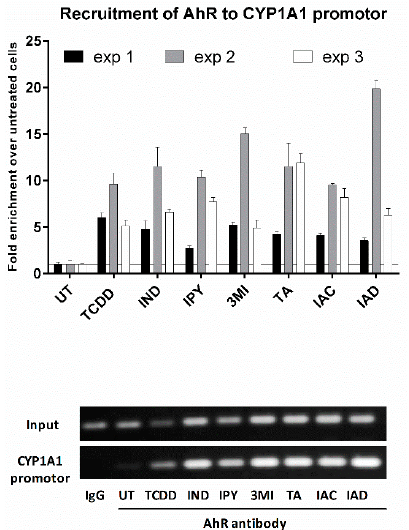
Figure 7. MICT elicit the binding of the AhR to CYP1A1 promoter, as determined by the chromatin immunoprecipitation assay (ChIP). LS180 cells were incubated with vehicle, TCDD, and tested compounds, as described in Materials and Methods, and were then subjected to ChIP analysis. Bar graphs show binding of the AhR to CYP1A1 promoter as quantified by RT-PCR. The entire protocol was carried out in three consecutive cell passages. The data are expressed as a fold enrichment to vehicle-treated cells and show the mean ± SD from duplicates (technical replicates). DNA fragments amplified by PCR were resolved on 2% agarose gel (representative record from “exp 2” is shown).